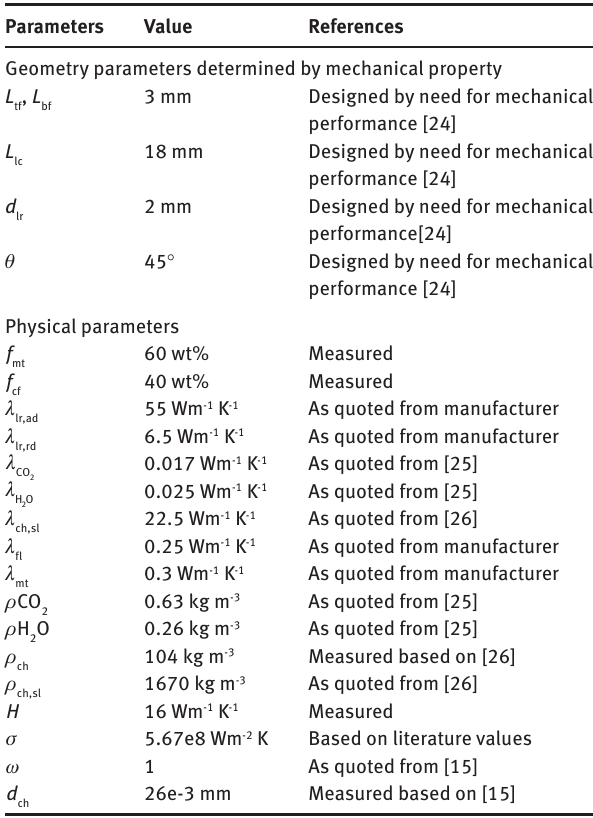
Table 1: Material and geometry parameters in the design